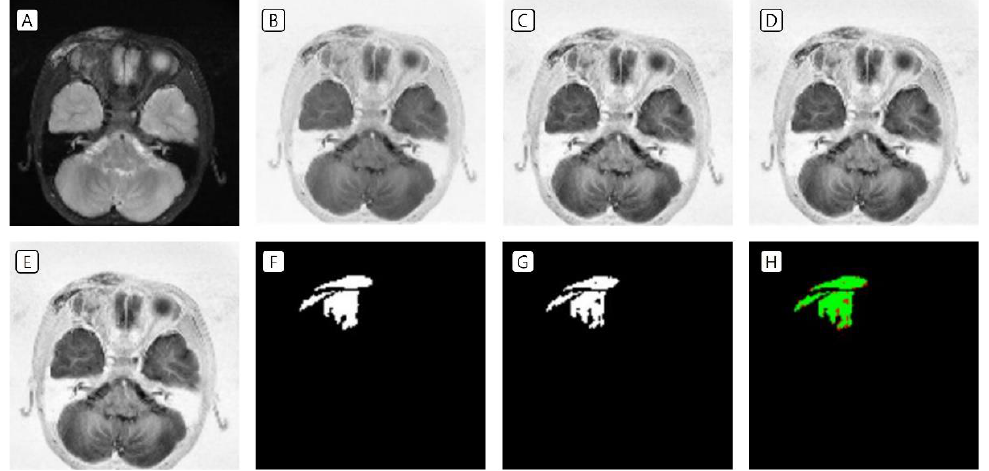
Figure 2. Training set of VMs in the right periorbital area. ( A ) Resized to a volume of 16, a height of 128, and a width of 128 pixels; ( B ) inverted image; ( C ) CLAHE application; ( D ) Z-score standardization; ( E ) minimum – maximum normalization; ( F ) labeling data drawn by the clinicians; ( G ) prediction data drawn by the artificial intelligence tool; and ( H ) green indicates the matched area, while red indicates the mismatched area. VMs, venous malformations; CLAHE, contrast-limited adaptive histogram equalization.